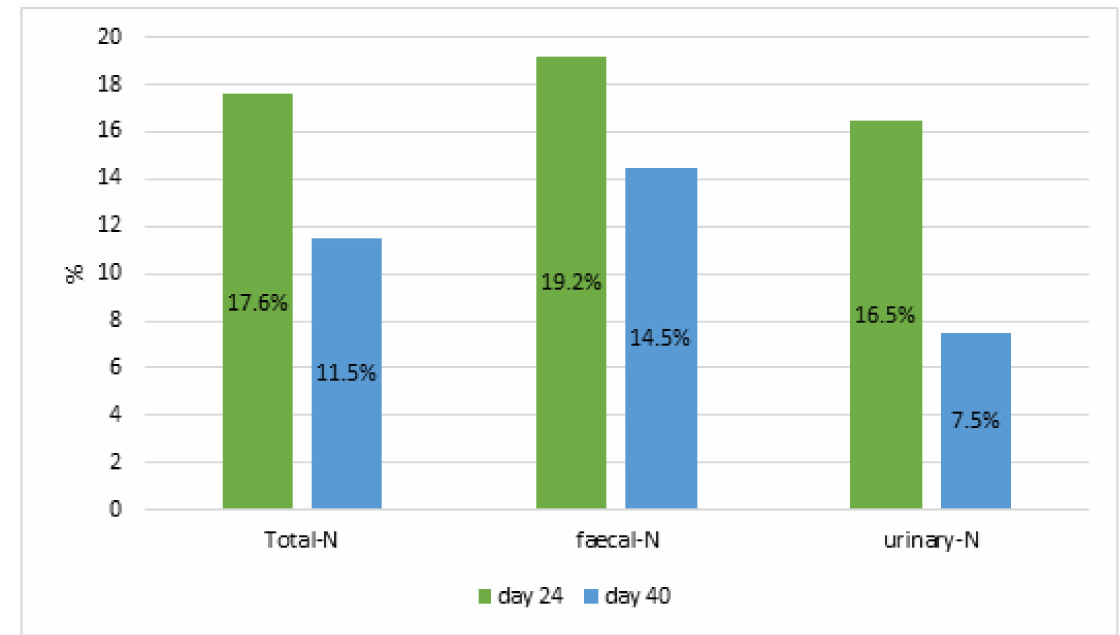
Figure 2. Effect of 1% dietary protein reduction on the decrease of excreted N of broiler